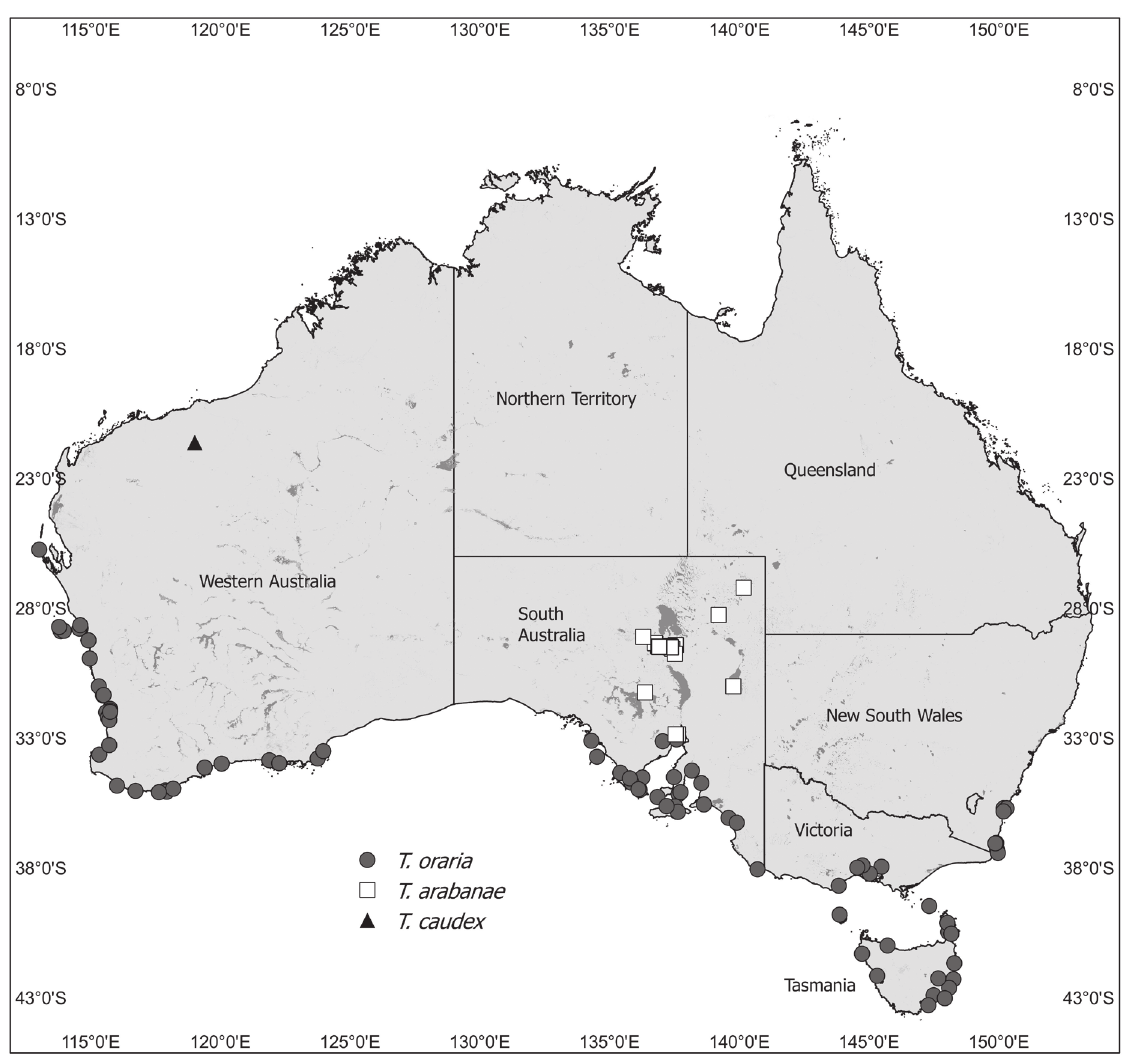
Fig. 9. Tetralycosa oraria (L. Koch, 1876), T. arabanae (Framenau, Gotch & Austin, 1976) and T. caudex sp. nov., distribution records in